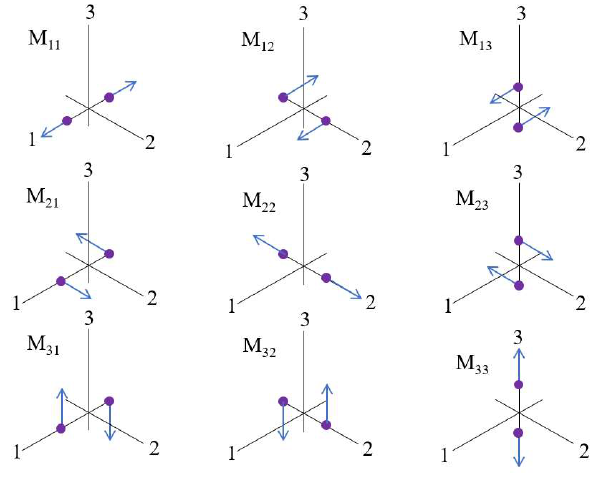
Figure 4. The nine force couples representing the components of MT.